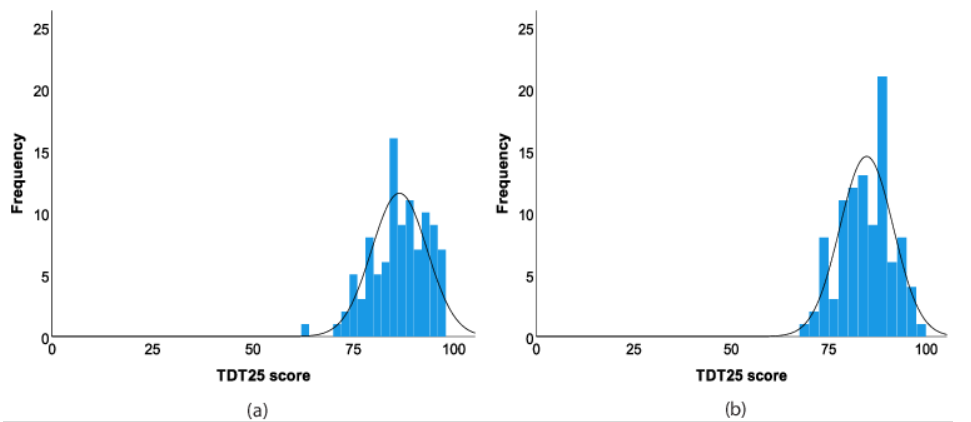
Figure 2. Frequency distributions of Tactile Discrimination Test (TDT) scores for ( a ) dominant and ( b ) non-dominant hands of neurologically healthy participants.